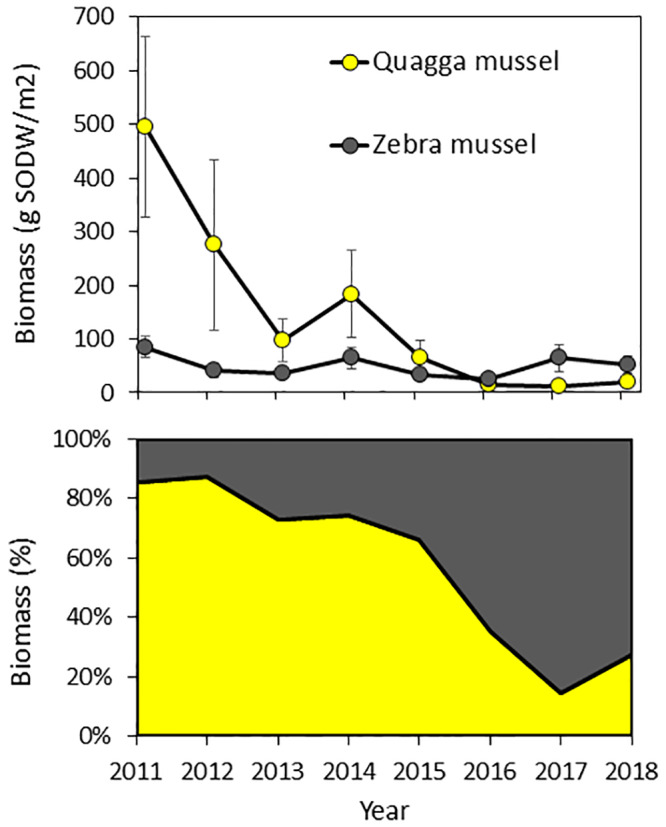
Biomass of zebra and quagga mussels in the 0–6 m bottom depths in Onondaga Lake from 2011 to 2018.Panel A: biomass with error bars indicating ± 1 SE. Panel B: the change in proportion by biomass of the two species.